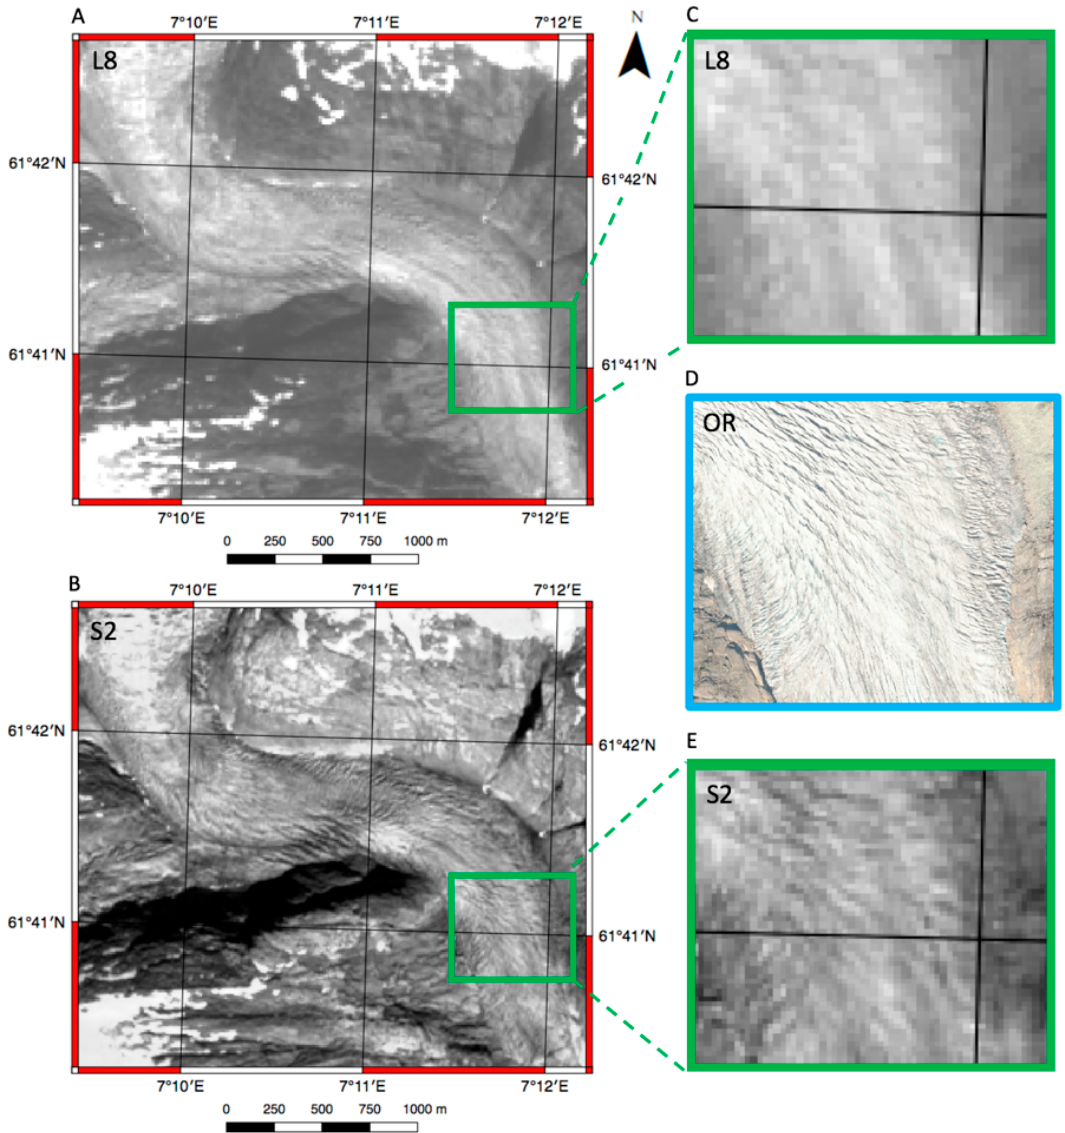
Figure 1. Comparison of Landsat 8 (L8) with Sentinel-2 (S2) and ortophoto (OR) of Nigardsbreen tongue and terminus using imagery acquired on 22.08.2017 (S2 and L8) and on 26.08.2017 (OR). ( A ) L8 band 8 image of 15 m ground resolution over the area of interest; ( B ) S2 band 8 image of 10 m ground resolution over the area of interest; ( C ) Close-up of the image A displaying minimal signs of crevassing; ( D ) Close-up of ortophoto displaying heavy crevassing in the upstream and lateral sections at 0.25 m ground resolution; ( E ) Close-up of the image B displaying clear crevassing in the upstream and lateral parts.